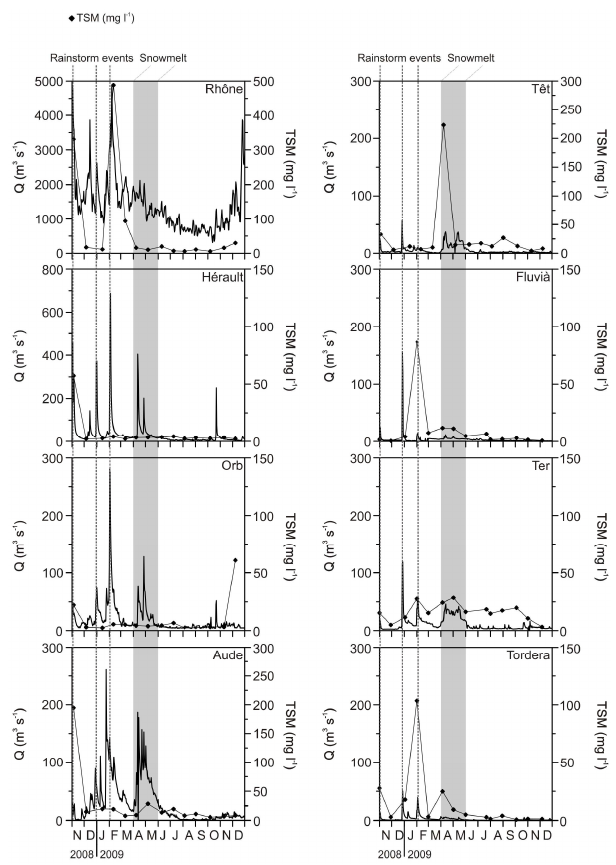
Figure 2. Average daily water discharge (Q) measured at the gauging station of each studied river from November 2008 to December 2009 by Compagnie Nationale du Rhône (Rhône River), Banque Hydro France (Hérault, Orb, Aude and Têt rivers) and Agència Catalana de l'Aigua (Fluvià, Ter and Tordera rivers) . The three storm events (November 2008, December 2008 and February 2009) that impacted the study area are shown as a dotted line and the snowmelt event is shown as a grey band. Plots show the temporal variability of total suspended matter (TSM) concentrations with corresponding average daily water discharge.